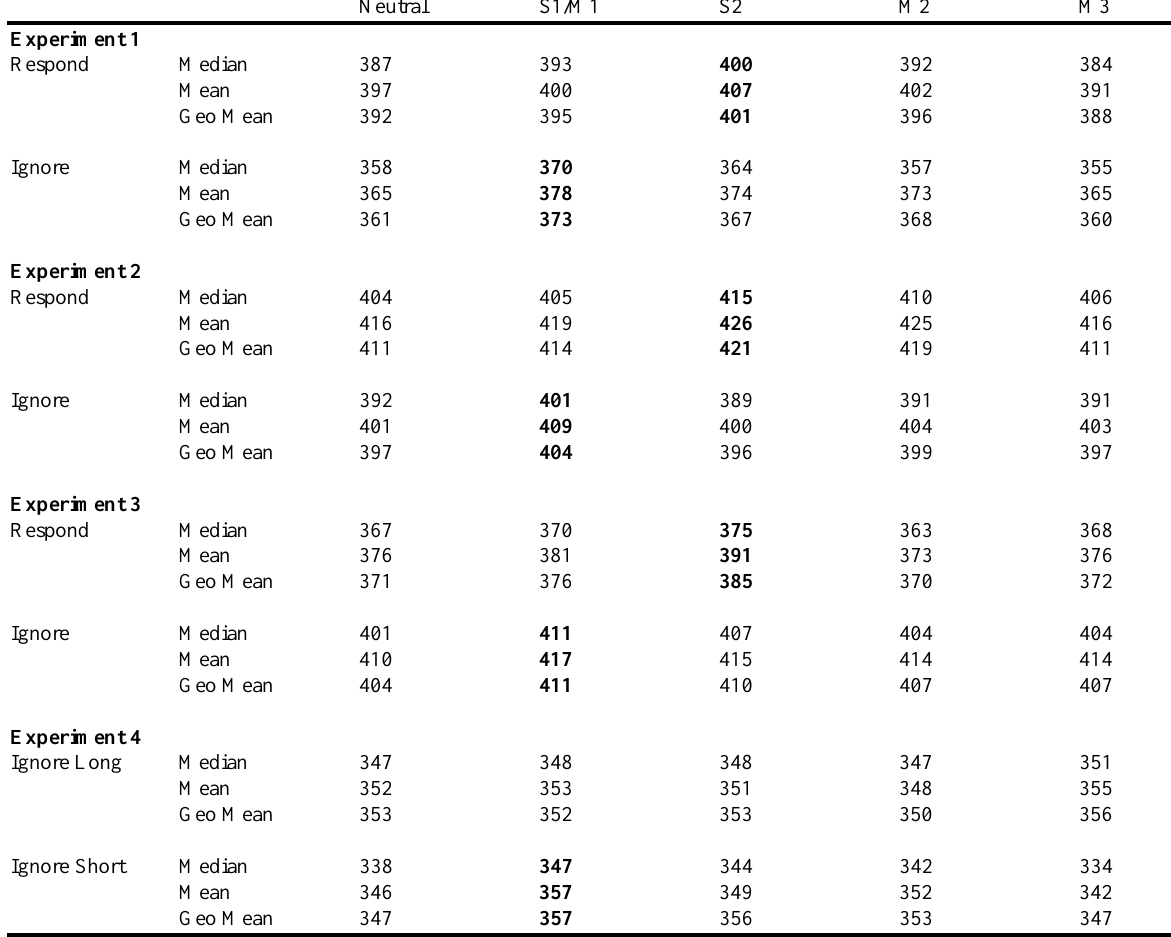
Comparison of median, mean, and geometric mean RTs for each condition of each experiment. Note that in all cases, where there are significant differences, the slowest RTs relative to the neutral conditions (indicated in boldface) are in positions S1/M1 for the Ignore condition and Ignore Short condition, and position S2 for the Respond condition. Neutral S1/M1 S2 M2